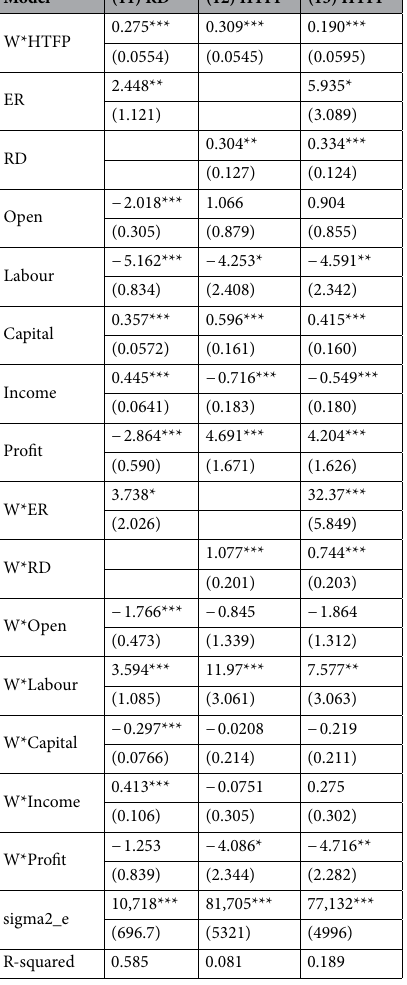
Table 7. Mediating effects of production technology. *, **, ***indicate significance at the 10%, 5% and 1% level, and the standard errors are in